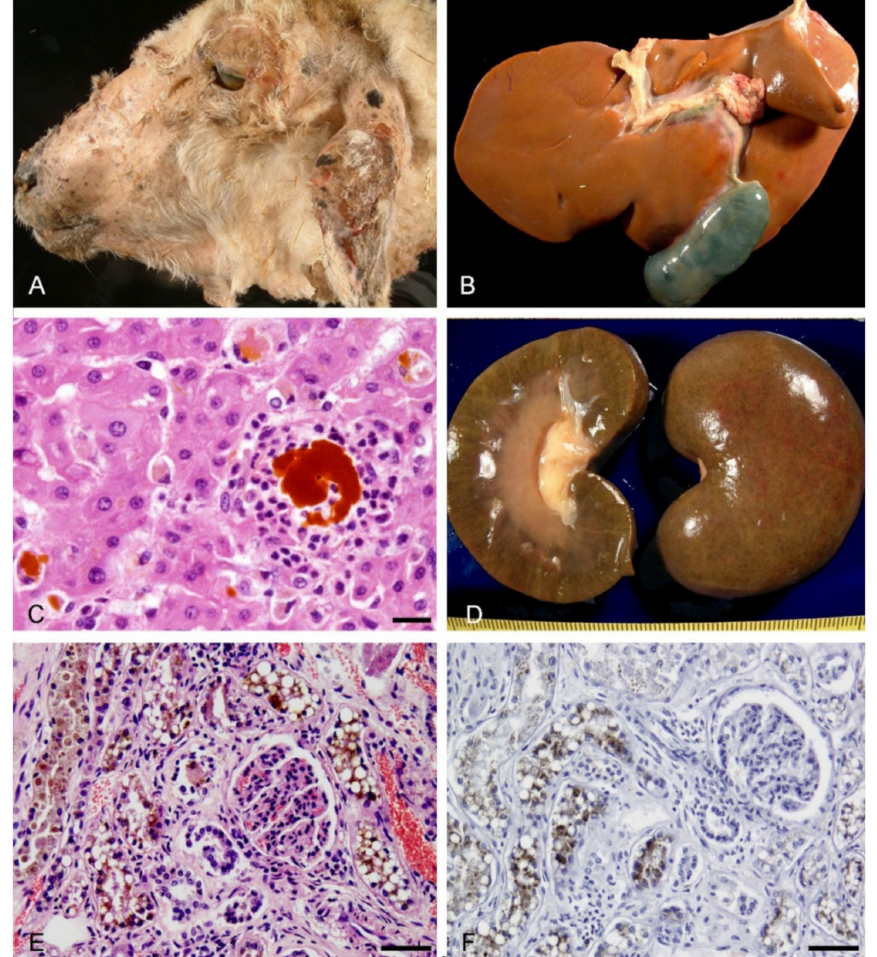
Figure 1. Acute lesions observed in naturally acquired cases of FE in sheep. ( A ) Sloughing of the skin in the ears, eyelids, muzzle and lips. ( B ) The liver was diffusely yellowish in color and the common and cystic bile duct were distended. ( C ) Polimorphonuclear neutrophils were surrounding a hepatic “bile lake”. HE. Bar, 20 µ m. ( D ) Linear greenish discoloration of the renal cortex and medulla. ( E ) Brown granular pigment in the proximal tubules. HE. Bar, 50 µ m. ( F ) Green granular pigment consistent with bilirubin in the proximal tubules. Hall ´ s bilirubin stain. Bar, 50 µ m. All sheep examined in the chronic stage showed vascular lesions in the liver. In portal hepatic arteries, hepatic arteries in the septa and large hilar hepatic arteries, near severely damaged intrahepatic (interlobular, septal) and extrahepatic (common and